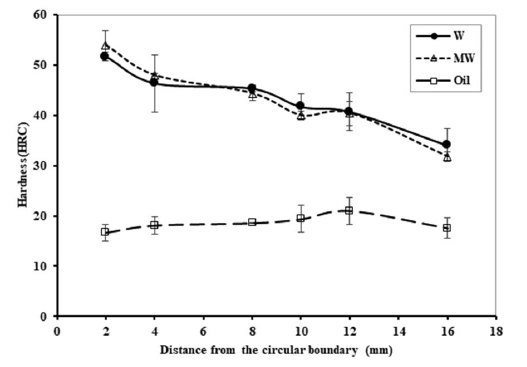
Figure 4. Hardness profiles by distance from circular boundary of specimen quenched in regular tap water (W), magnetically treated tap water (MW), and oil quenchant.